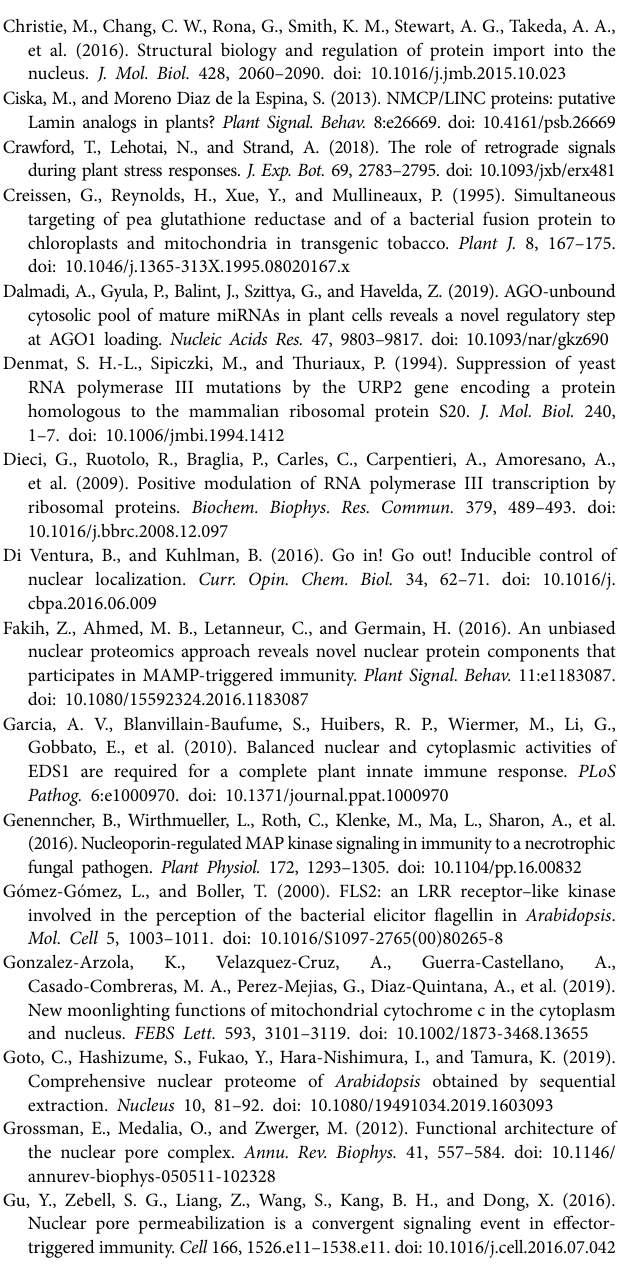
Supplementary File 1 | T ables containing the protein lists from the study.